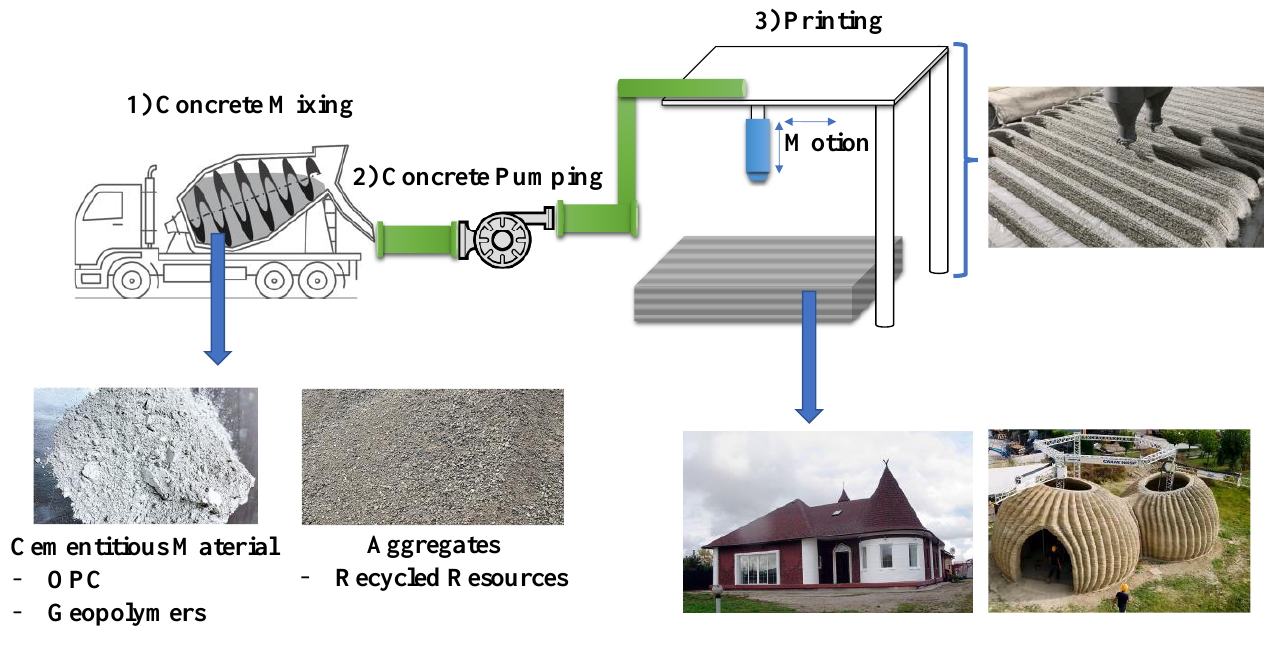
Figure 3. 3DCP Process [29–36].